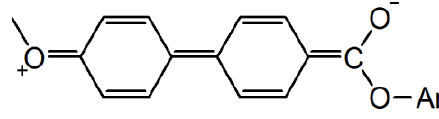
Figure 7. The resonance structure of biphenylcarboxylate